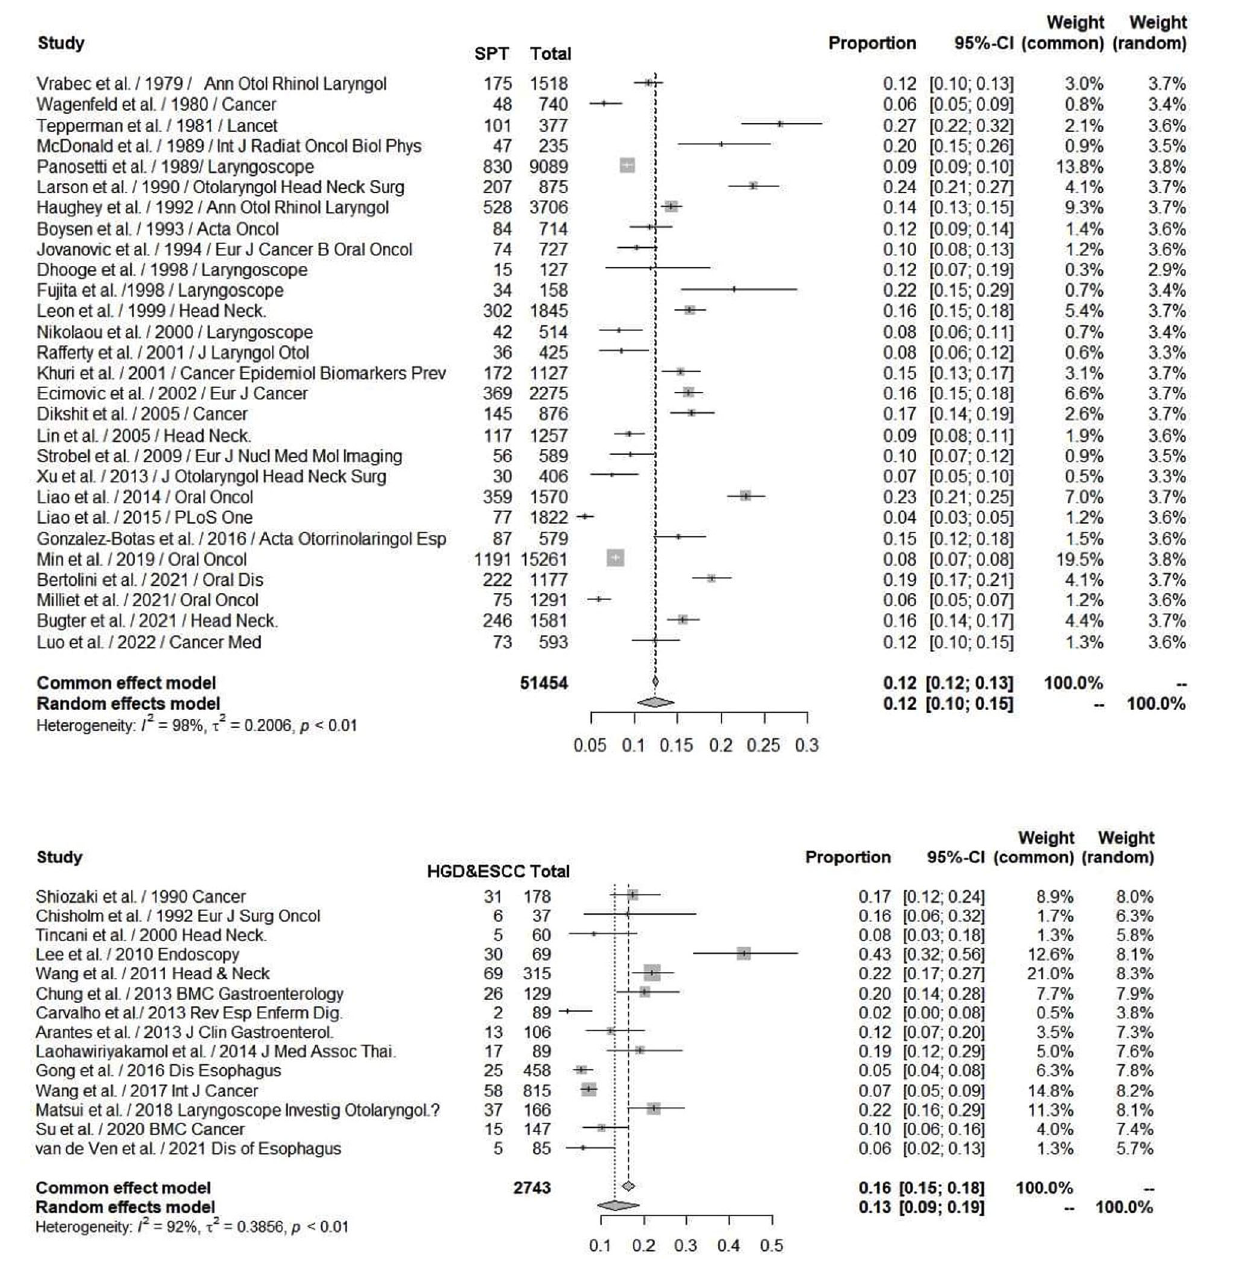
FIGURE 3 | Upper : Forest plots showing the reported proportion of SPTs among head and neck cancers with a random effect models due to signi fi cant heterogeneity, the overall SPT rate was 12% (95% CI, 10-15%). Lower : Forest plots showing a reported 13% incidence rate of HGD and ESCC (95% CI, 9-19%) by image-enhanced endoscopy screening among head and neck cancer patients. ESCC, esophageal squamous cell carcinoma; HGD, high-grade dysplasia; SPT, second primary